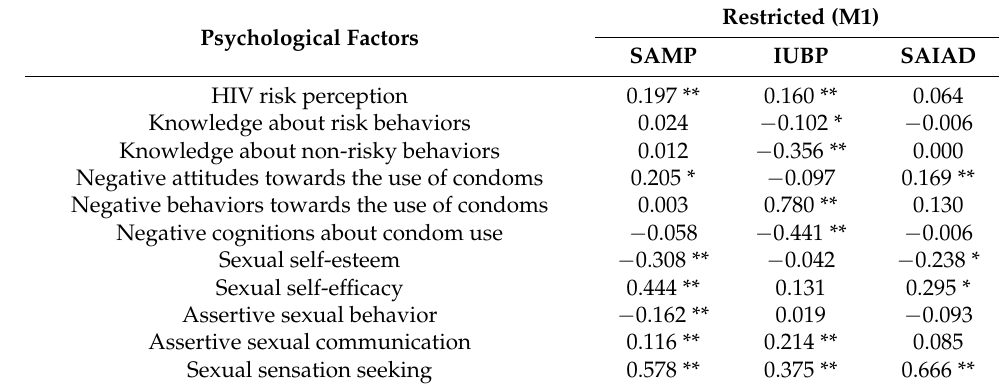
Table 3. Standardized effects of the SET-ESEM